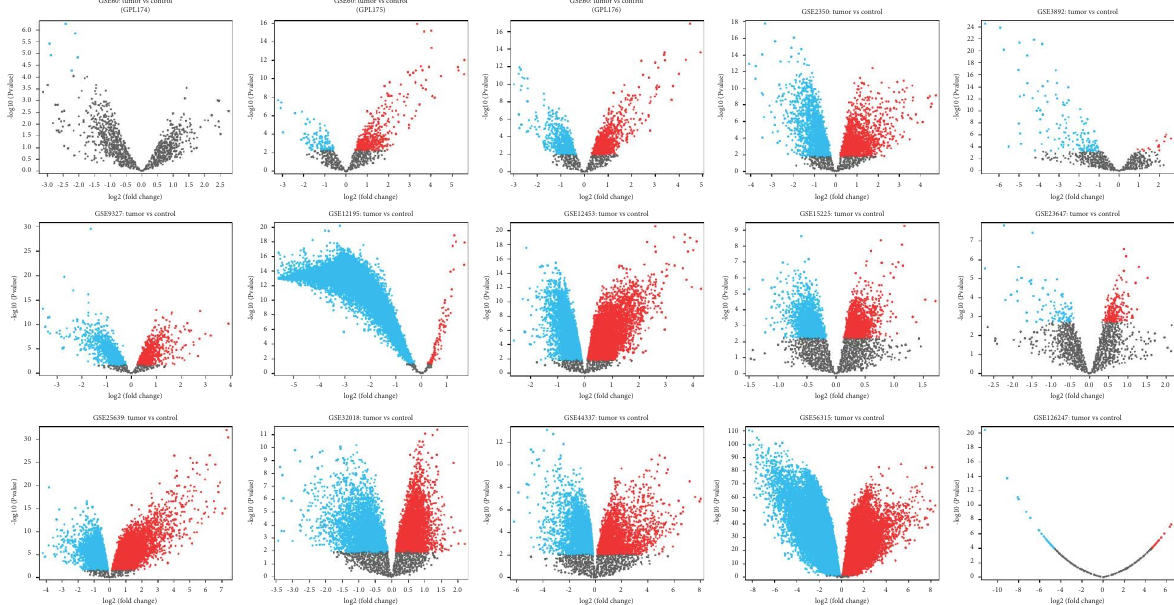
Figure 1: Volcano plots of DEGs detected in 15 datasets from GEO database. Red, blue, and black dots denote upregulated genes, downregulated genes, and nonsignifcant genes,